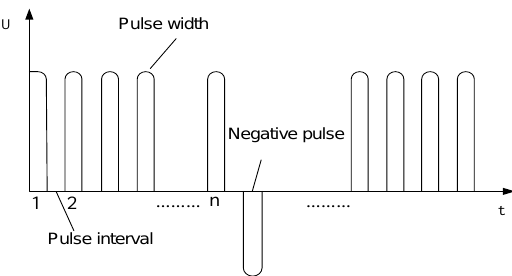
Figure 9. Structure diagram of pulse waveform.